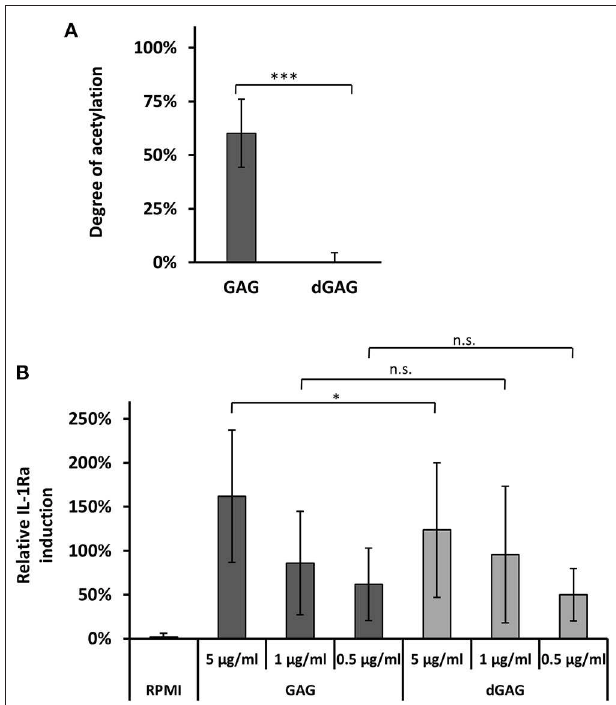
FIGURE 1 | De- N -acetylation of GAG. Degree of acetylation (DA) of GAGs (A) . DA was determined by an acetate assay (GAG, native polymer; dGAG, de-N-acetylated) (B) . In vitro IL-1Ra secretion in PBMC supernatants in presence of GAG. LPS (10ng/ml) served as external standard and were set to 100% in each biological replicate. Statistical analysis by WMW test in comparison to GAG: ns, non significative; * p < 0.05; *** p <